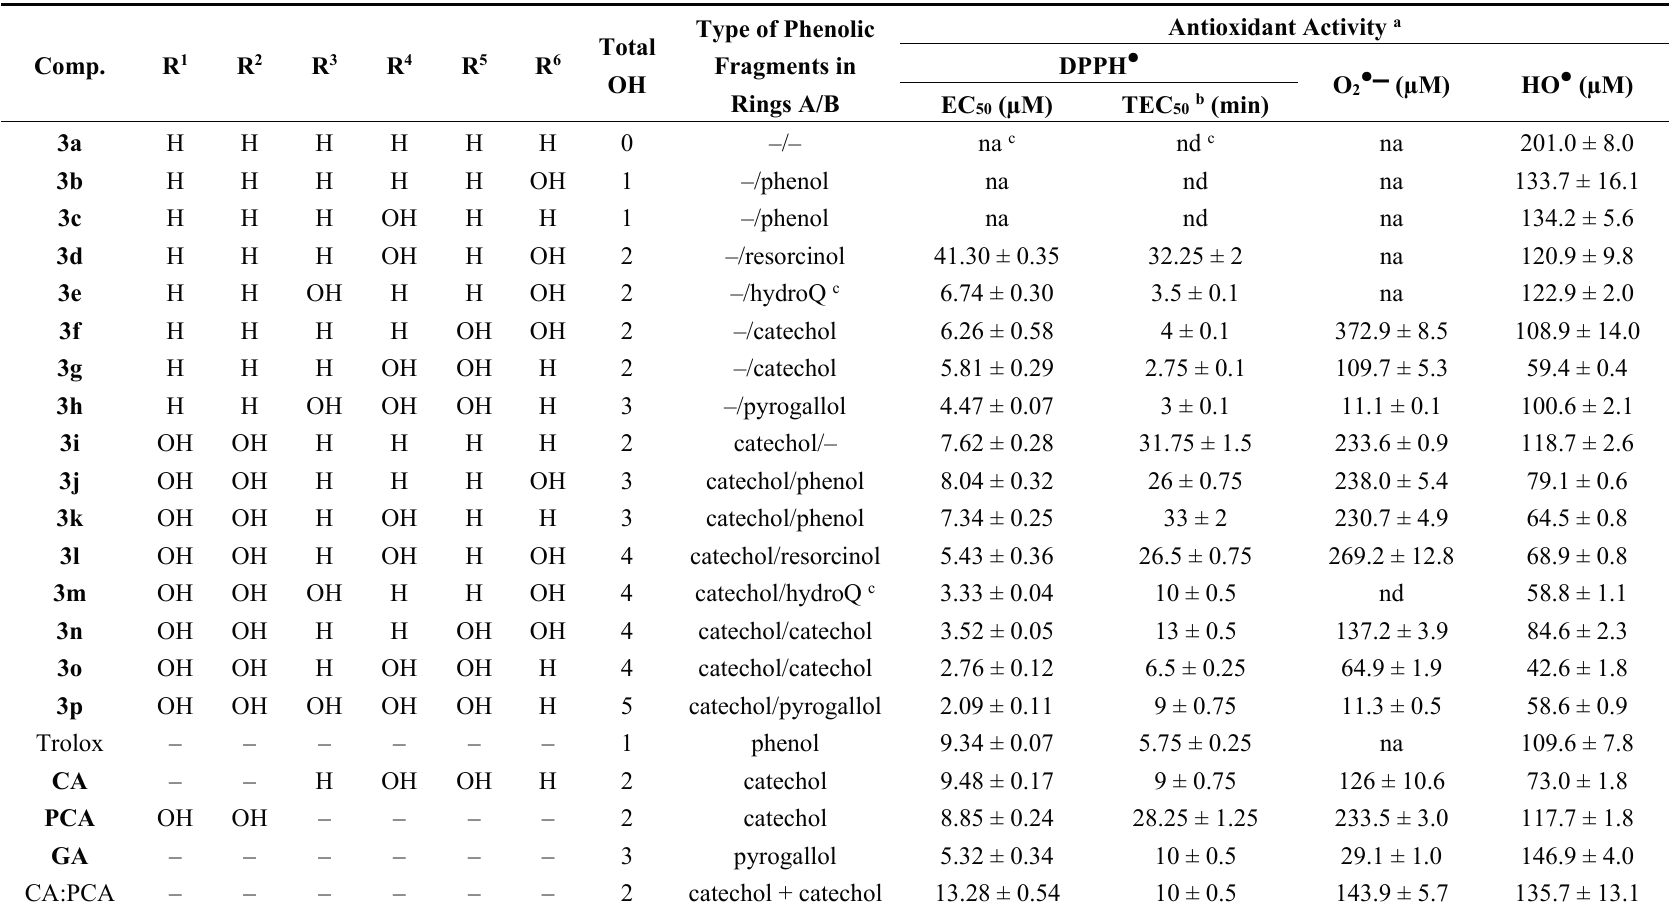
Table 1. Substitution patterns, number of hydroxyl groups, type of phenolic fragments, and antioxidant activity (EC 50 ± SD) of compounds 3a – p and standard